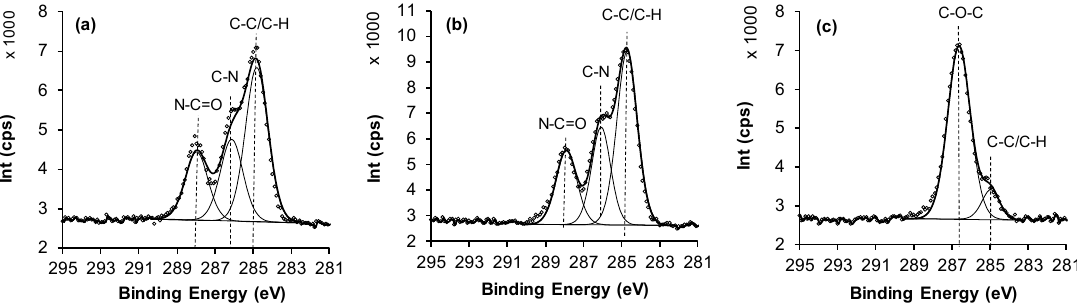
Figure 5. C 1s XPS spectra after BSA adsorption to the: ( a ) Si wafer (control), ( b ) the APTES surfaces and ( c ) high density PEG layer surface. Table 3. XPS elemental compositions for BSA adsorbed to Si wafer, APTES and PEG surfaces grafted under different conditions at 60 °C.